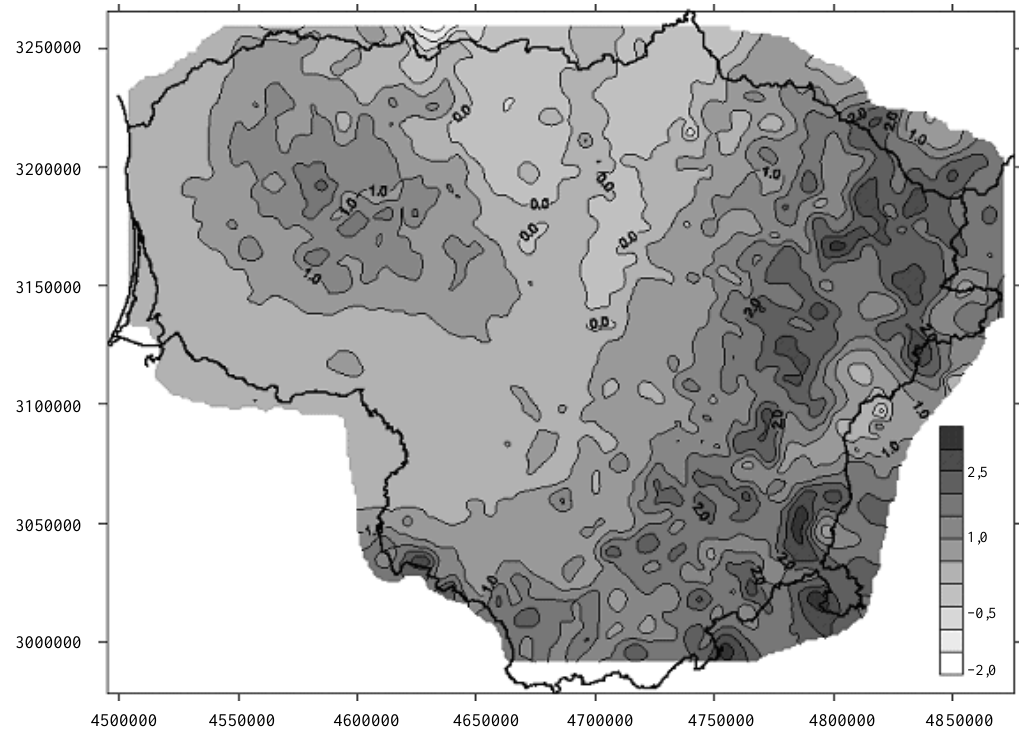
9 pav. Skirtumas tarp patikslinto ir ankstesnio Bouguer anomalij ų žem ė lapi ų Fig 9. Difference between new and old models of Bouguer anomalies